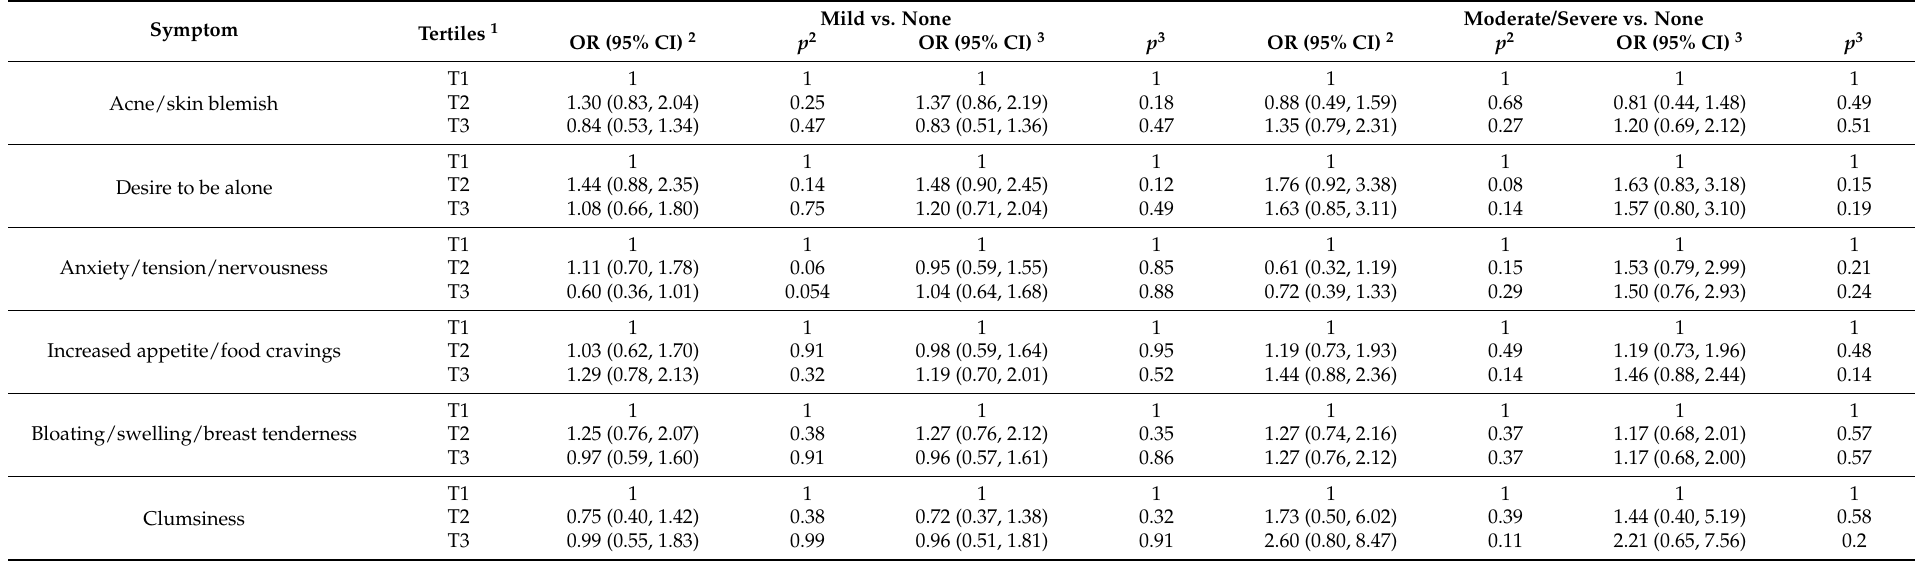
Table 5. Unadjusted and adjusted Odds Ratios and 95% CIs for the association between tertiles of plasma retinol and premenstrual